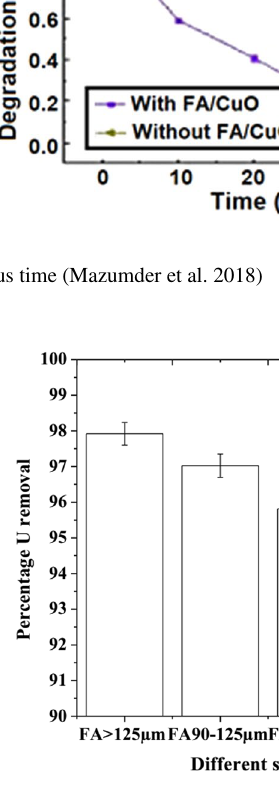
Fig. 17 Effect of particle size fraction on removal of U (Police et